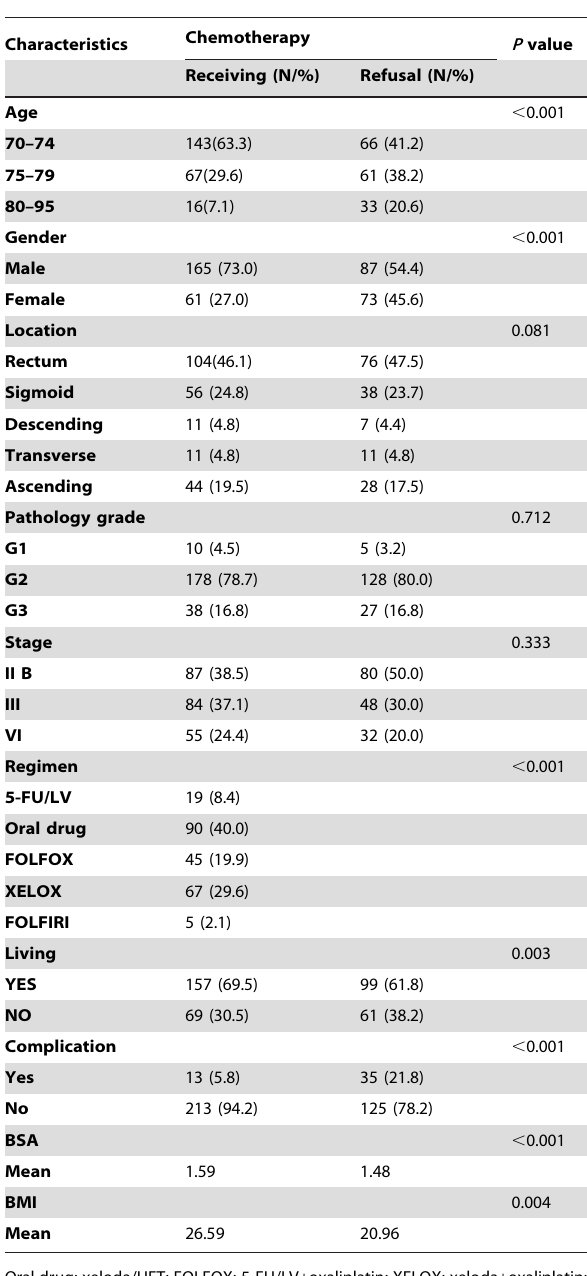
Table 1. Clinicopathological characteristics of